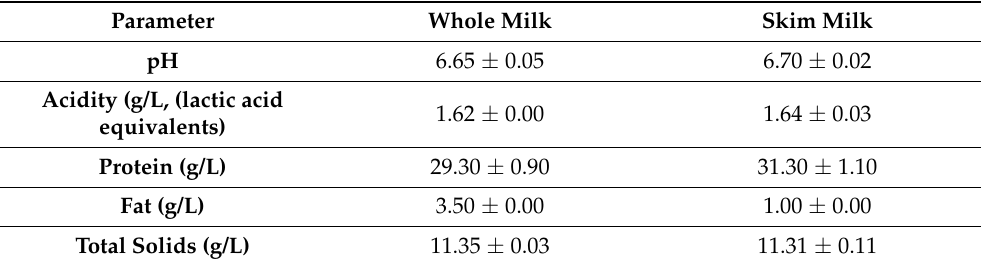
Table 1. Physicochemical parameters of the whole and skim milk